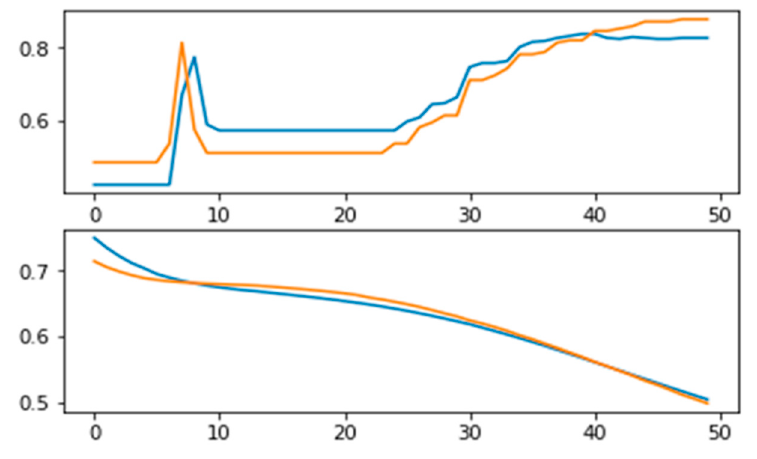
Figure 4. Training and validation accuracy (above) and loss (below) for the emotion module.